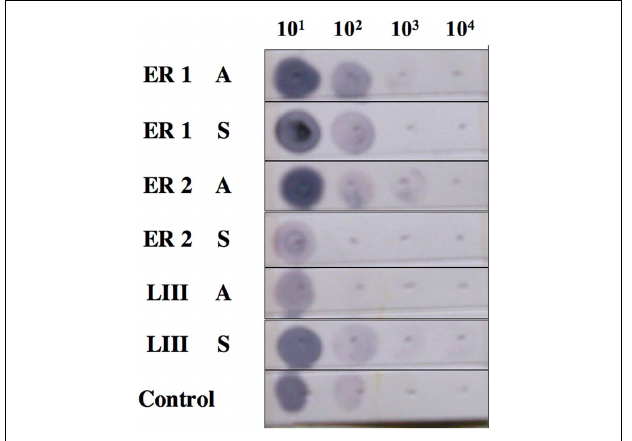
FIGURE 3 | DIG-labeled In situ hybridization for lamprey ER. Light micrographs of sagittal tissue sections showing reaction product using probe ER2 within the olfactory bulb (A) , the hypothalamus (B) , and the midbrain (C) . (200 ×